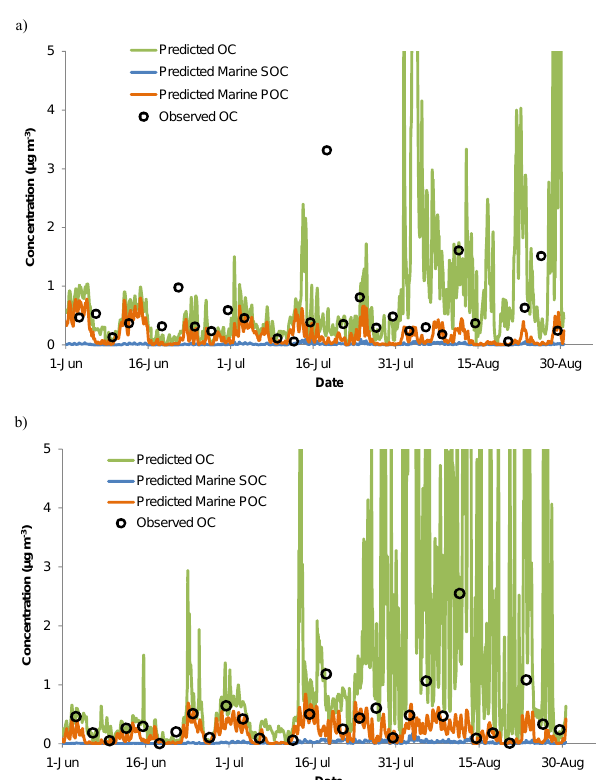
Fig. 2. Time series of hourly top-down model-predicted surface OC 2 . 5 , marine primary and secondary OC 2 . 5 and 24-h average ob- served OC 2 . 5 for the (a) Point Reyes and (b) Redwood IMPROVE sites. The concentration values above 5µgm − 3 are not shown.